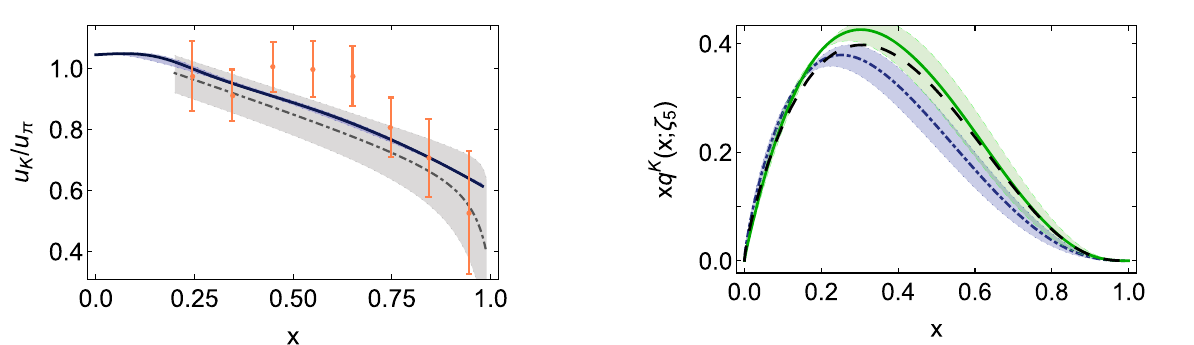
Fig. 12 u K ( x ; ζ 5 )/ u π ( x ; ζ 5 ) . Solid blue curve – result obtained for the ratio after ζ H → ζ 5 evolution of Eq.(29) [ π ] and Eq.(47) [ K ]. (Eq.(52) provides aninterpolationfor thiscurve.) The lighter-blue band bracketing the curve reveals the effect of ζ H → ζ H ( 1 . 0 ± 0 . 1 ) : it is negligible.Dot-dashedgreycurvewithingreyband–lQCDresult[120]. Data (orange) from Ref. [119]